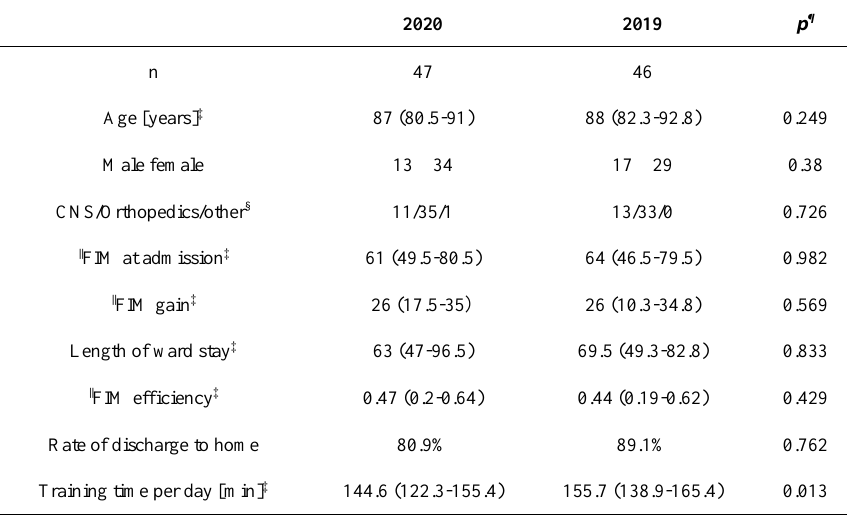
Table 2. Basic information and evaluation indices for discharged